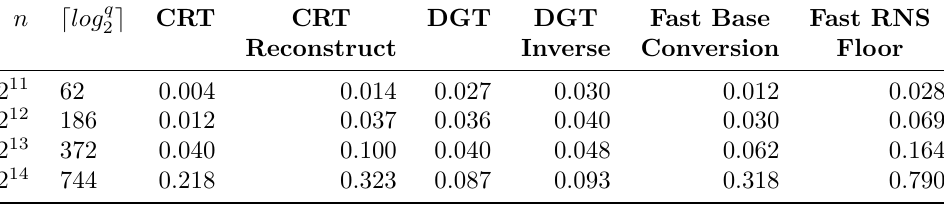
Table 7: Latency in (millisecond) of core compute kernels on NVIDIA Tesla P100. n d log q 2